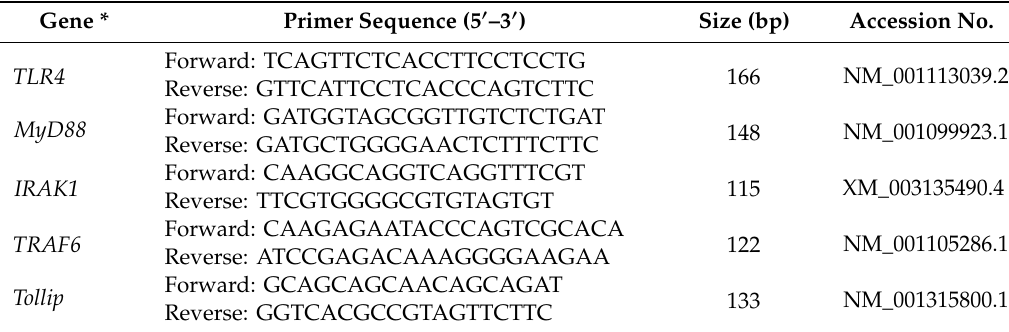
Table 2. Primer sequences for quantitative real-time polymerase chain